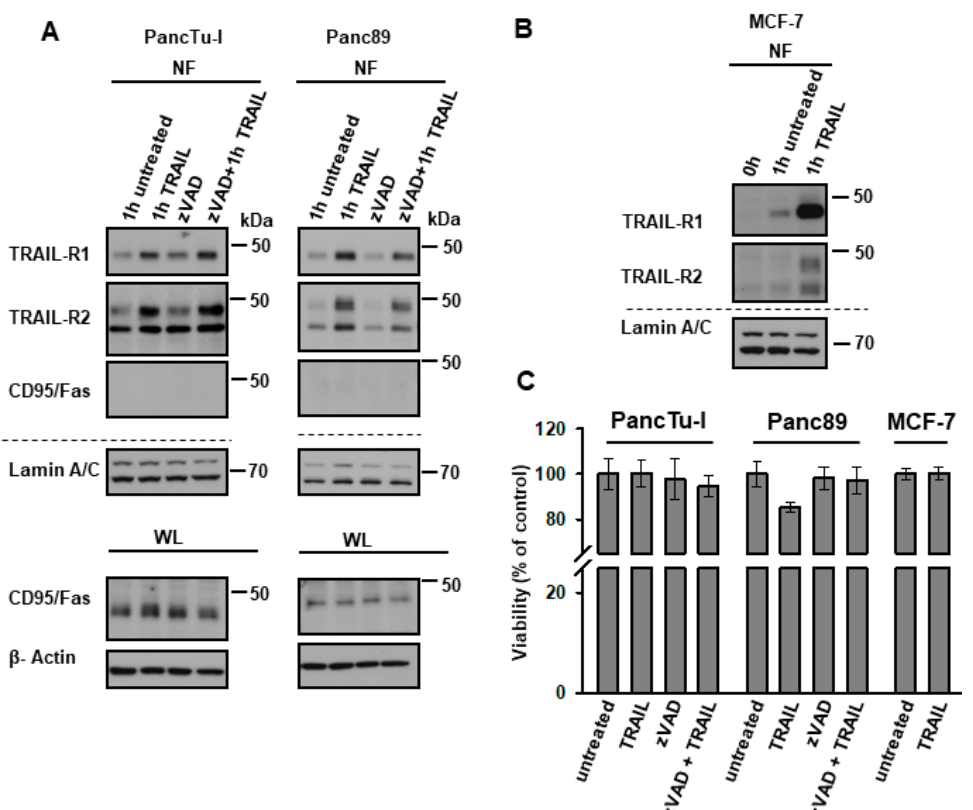
Figure 4. TRAIL-induced nuclear translocation of TRAIL-R1 and TRAIL-R2 is independent of their death-inducing activity. ( A ) PancTu-I cells and Panc89 cells were incubated with or without zVAD-fmk (1 h, 50 µM/mL) followed by biotinylation of surface proteins at 4 °C. Protein trafficking was released for one hour at 37 °C in the presence or absence of recombinant TRAIL (20 ng/mL) and zVAD-fmk. Nuclear fractions (NF) were isolated and biotinylated protein-complexes were affinity purified using streptavidin-conjugated beads. Precipitates were analyzed by Western blotting for the presence of TRAIL-R1, TRAIL-R2 and CD95/Fas. Protein lysates were immunoblotted for Lamin A/C (NF marker) as control for the equal amounts of extracts used for purification of biotinylated-proteins. The corresponding whole lysate (WL) were blotted for CD95/Fas, and β -Actin was used as loading control. ( B ) Biotinylated surface proteins were also tracked in MCF7 cells similar to ( A ). ( C ) Viability assays were performed in PancTu-I, Panc89, and MCF7 cells, as described in Material and Methods. Cells were treated with or without 50 µM/mL zVAD-fmk for 1 h, followed by stimulation with 20 ng/mL recombinant TRAIL for 24 h.